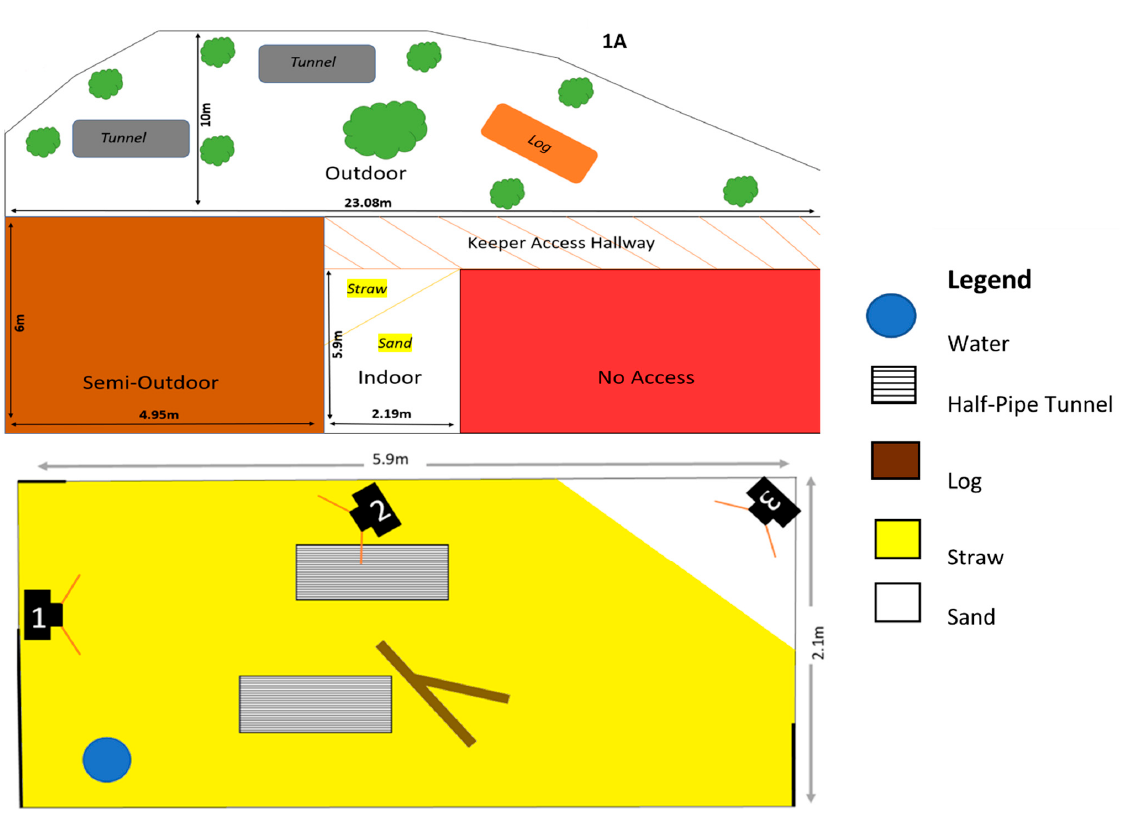
Figure A2. A, the new enclosure for the leopard tortoises post change. Top is view of full enclosure. Bottom is a detailed diagram of the indoor only section with camera placement.